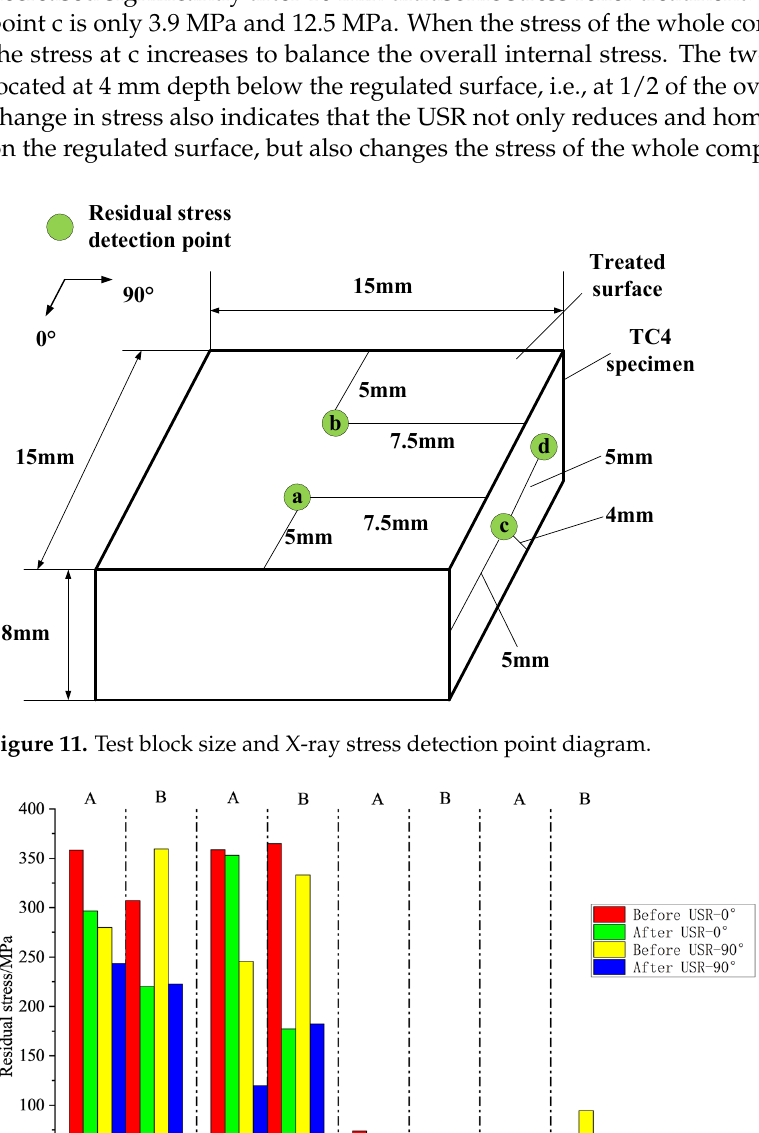
( b ) Figure 13. XRD diffraction patterns before and after ultrasonic treatment: ( a ) 1#; ( b ) 2#. Comparing the XRD patterns of A and B blocks before and after treatment, it was found that the main diffraction peak value and the width of each derivative peak changed. The change in X-ray diffraction peak width is mainly caused by lattice distortion and grain refinement, and the relationship is as follows: 2 tan s δ ε θ= (2) where s δ is the change in diffraction peak width caused by lattice distortion, θ is the diffraction angle. That is, the half width height of diffraction peak width can be observed